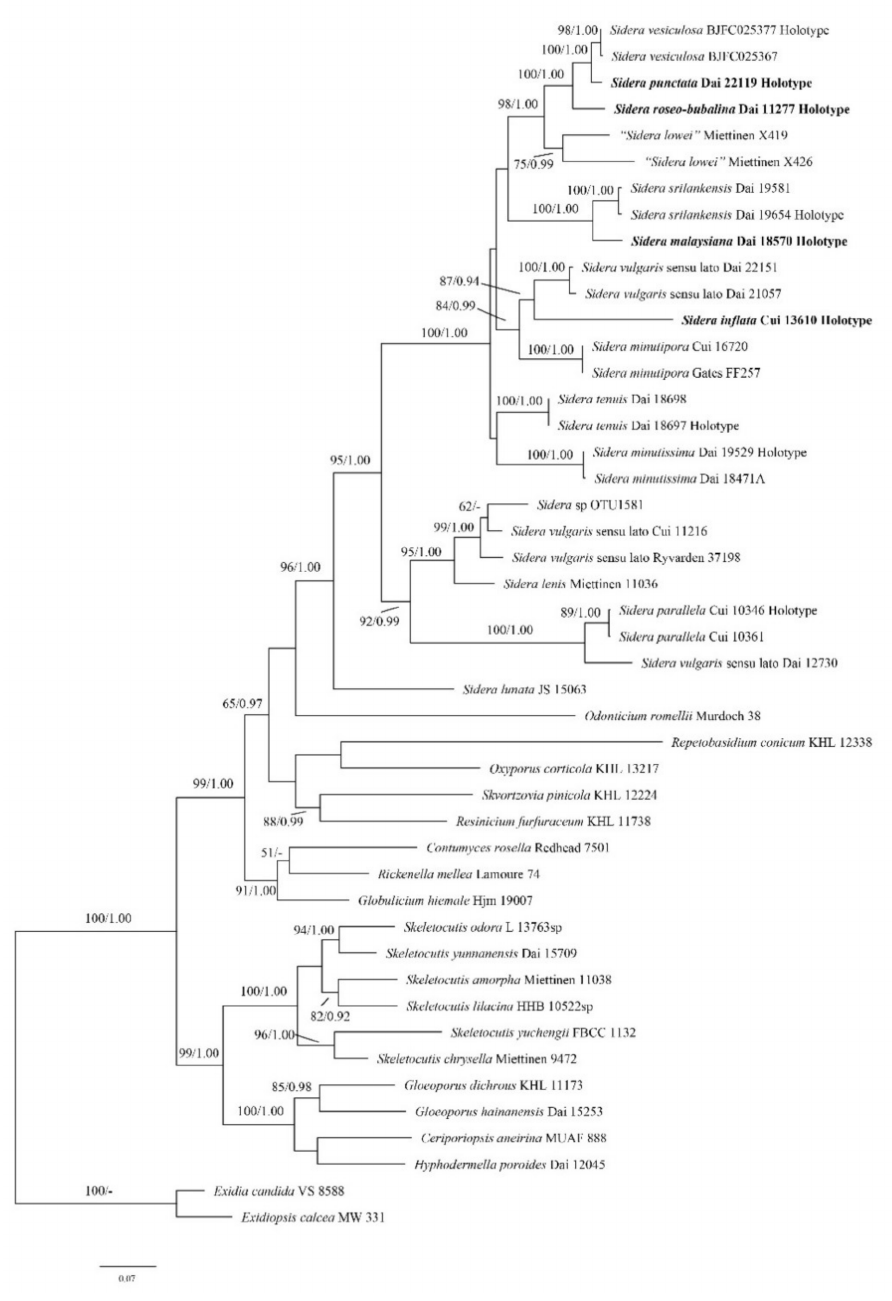
Figure 3. Phylogeny of Sidera and related species generated by ML analyses based on combined ITS + nLSU + RPB1 + RPB2 + TEF1 + mtSSU + nSSU sequences. Branches are labeled with maximum likelihood bootstrap >50% and Bayesian posterior probabilities >0.90, respectively. New species are indicated in